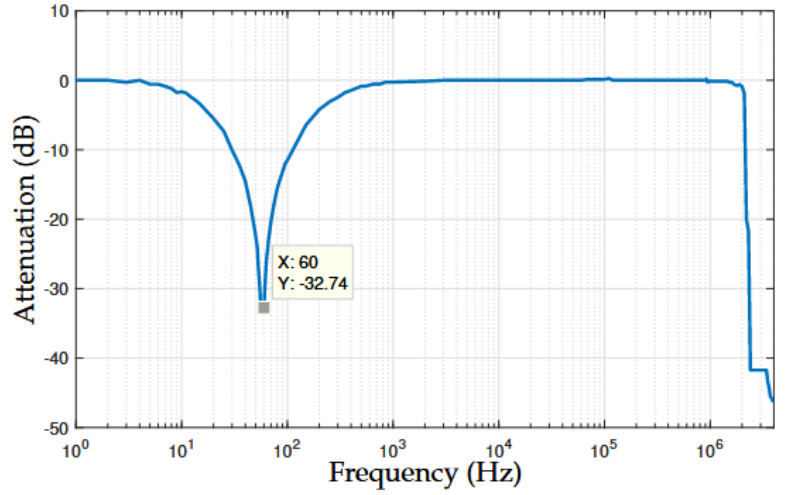
Figure 9. Attenuation of the prototype of the NB–PLC notch coupling